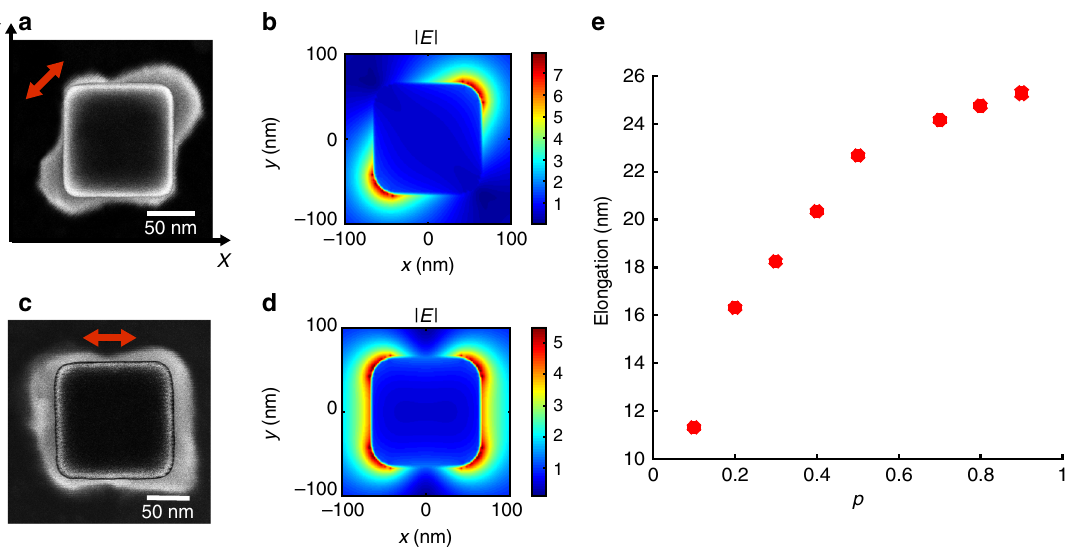
Fig. 2 Au nanocube-based hybrid nanostructures made by plasmonic 2-photon polymerization. a SEM image of the hybrid structure obtained with incident normal laser beam polarized along the cube diagonal (red arrow), λ = 780 nm. Image of the bare nanocube prior to photopolymerization is superimposed to highlight the polymer shell. b Finite difference time domain (FDTD) map of the fi eld modulus |E| in the vicinity of the Au nanocube in polymer corresponding to case a , mid sectional horizontal plane, λ = 780 nm. c SEM image of the hybrid nanostructure obtained with incident polarization along the cube side edge (red arrow). Image of the bare nanocube prior to photopolymerization is superimposed to highlight the polymer shell. d FDTD map of the fi eld modulus |E| in the vicinity of the Au nanocube in polymer corresponding to case c , mid sectional horizontal plane, λ = 780 nm. e Measured polymer elongation along the nanocube diagonal, case a , as a function of the normalized incident dose p used for plasmonic 2-photon polymerization, as determined by SEM